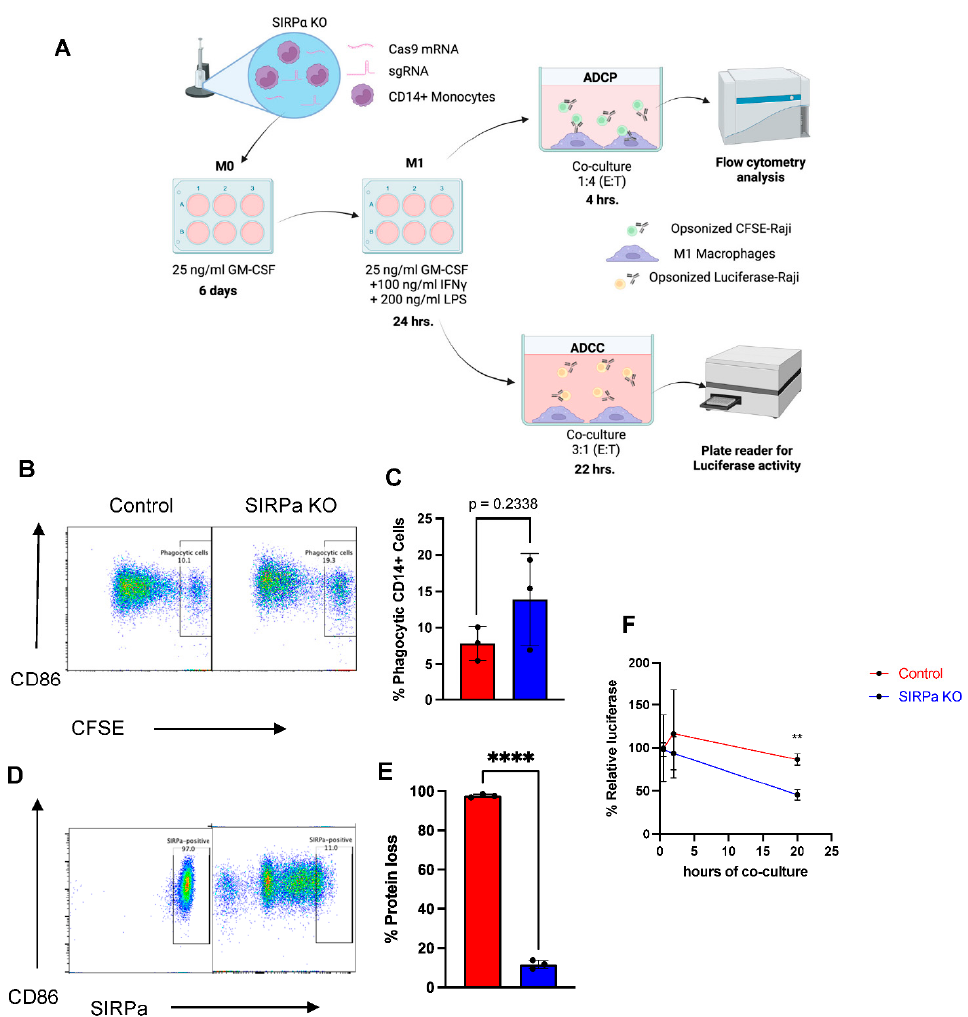
Figure 7. SIRPa KO in monocytes to enhance anti-tumor activity. ( A ) Schematic depicts experimental timeline for ADCP and ADCC. ( B ) Representative flow plots and ( C ) bar graph depicting percentage of phagocytosis as measured by CFSE dye follow coculture of monocytes with CFSE-labeled target cells. ( D ) Representative flow plot depicting and ( E ) bar graph showing frequency SIRPa in M1 macrophages following editing with Cas9 and SIRPA gRNA. ( F ) Percentage relative luciferase activity in cocultures of SIRPa KO monocytes or unedited controls with opsonized, luciferase-labeled controls. Statistical analysis was performed using either Student’s t test or two-way ANOVA followed by Sidak’s multiple comparisons test (n = 3 independent biological donors) (** p < 0.01, **** p < 0.0001).